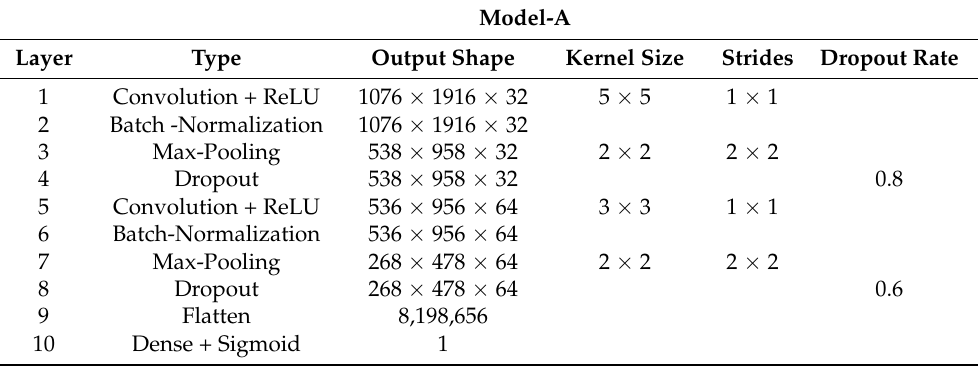
Table 1. Summary of self-developed CNN network: Model-A for DFDC image